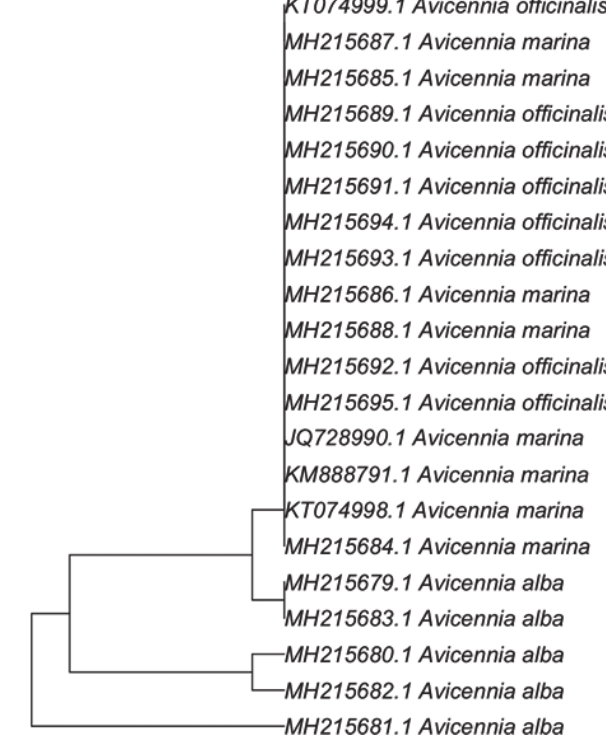
Figure 1. ML Phylogenetic tree of Avicennia species based on ITS sequences.